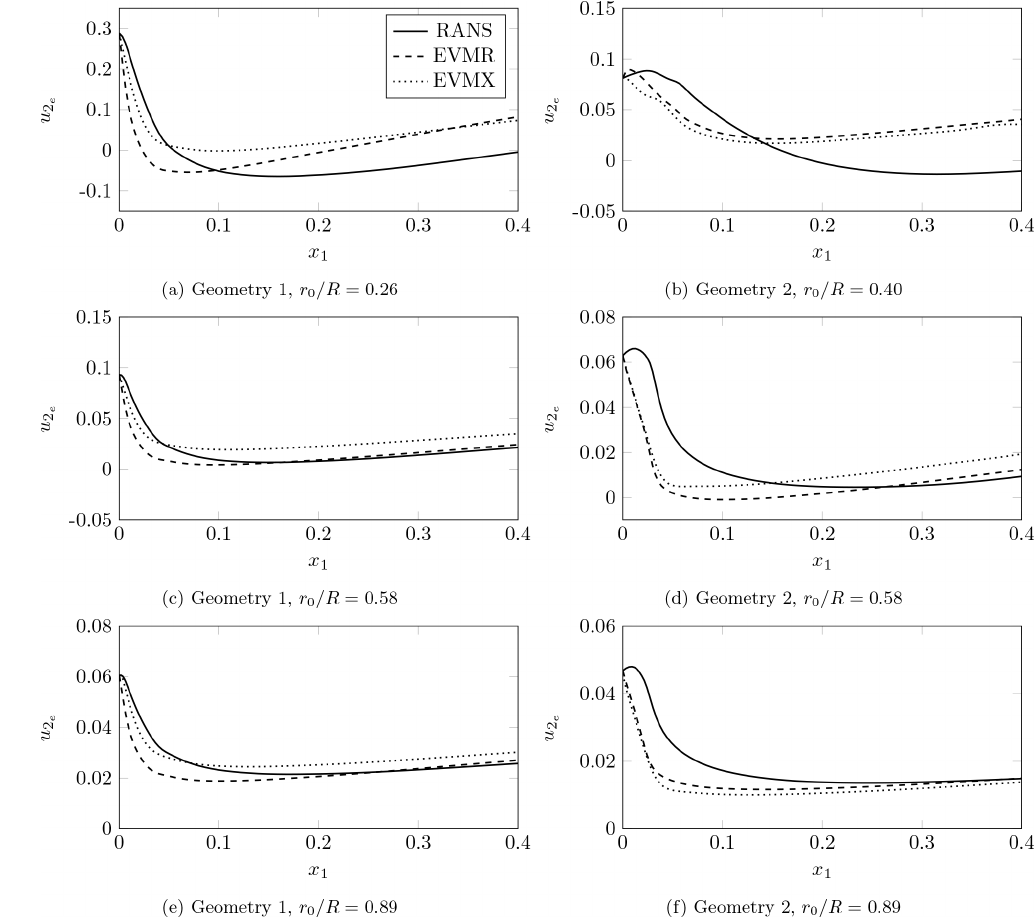
Figure 5. Spanwise edge